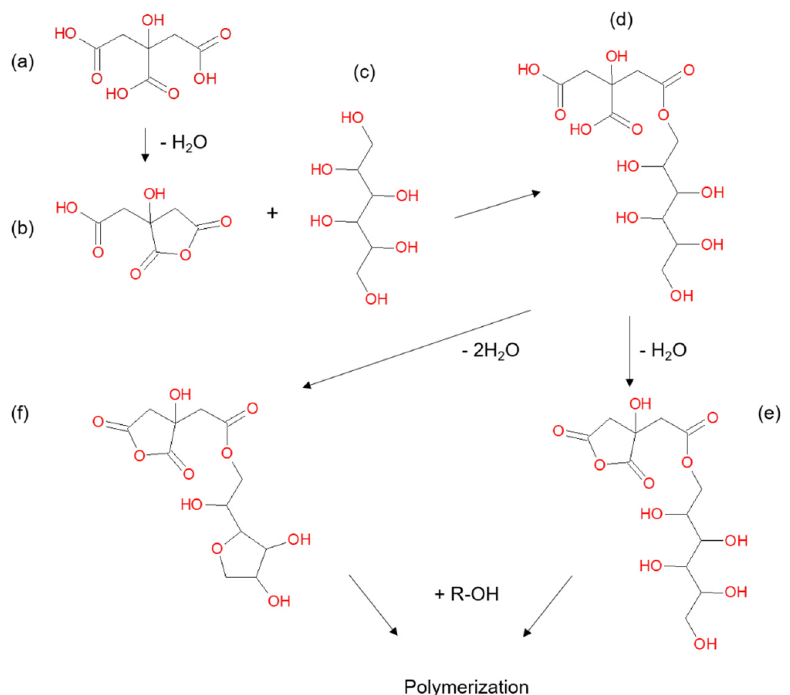
Figure 1. Reaction scheme for polymerisation of citric acid ( a ) and sorbitol ( c ) through a cyclic anhydride intermediate ( b ) to form an ester ( d ). Further condensation reactions can lead to the formation of another cyclic anhydride ( e ) and / or anhydrosorbitol ring ( f ) which undergo further reactions to form a polymerized material. Adapted from Doll et al. [17].